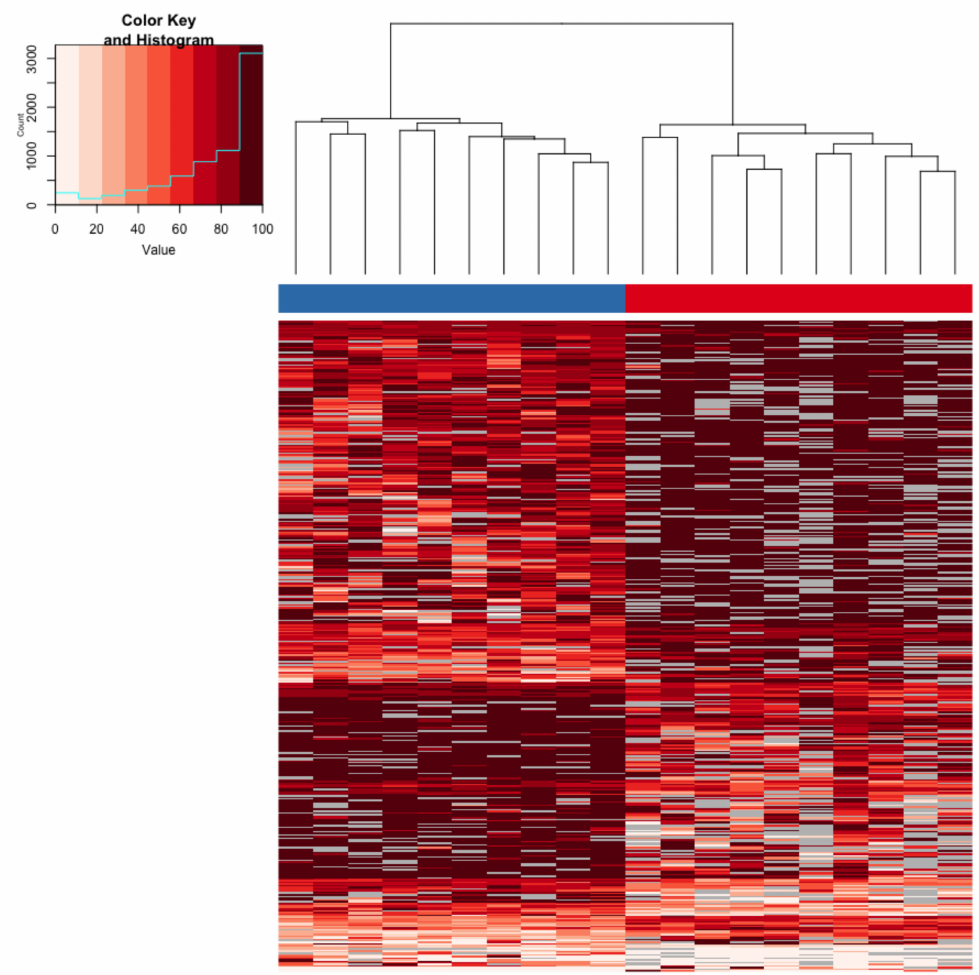
Figure 4. Hierarchical clustering of hepatic di ff erentially methylated cytosines (DMCs) from the Immediate time-point. The rearing-group is identified by color (hatchery = blue, stream = red) at the top of the column. Each row represents a DMC. The heatmap depicts percent methylation for each DMC for each individual with the darkest red indicating 100% methylation and the lightest indicating 0% methylation. The regions that did not meet the coverage cuto ff for a particular individual are represented by gray